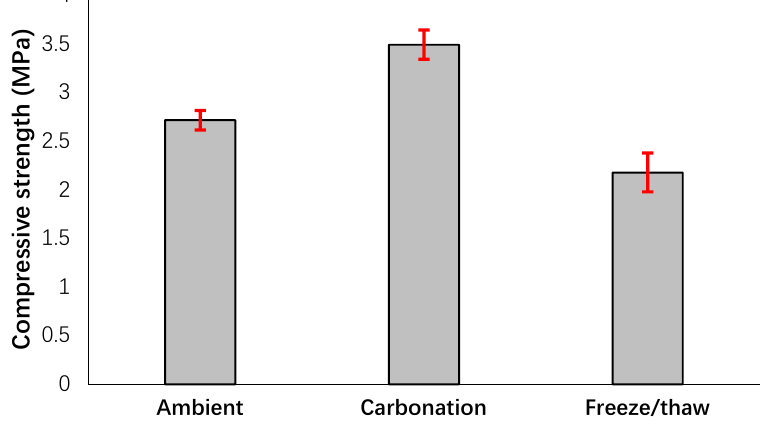
Figure 10. Effects of different conditions on the compressive strength.